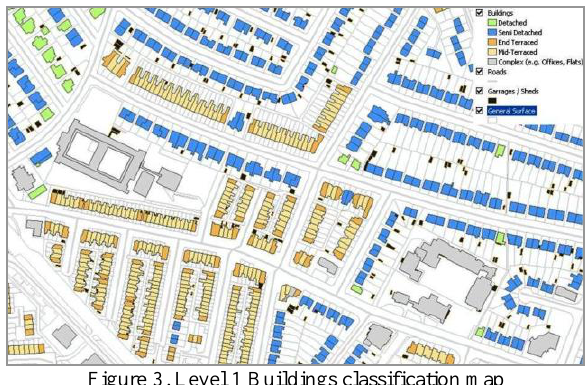
Figure 3. Level 1 Buildings classification map